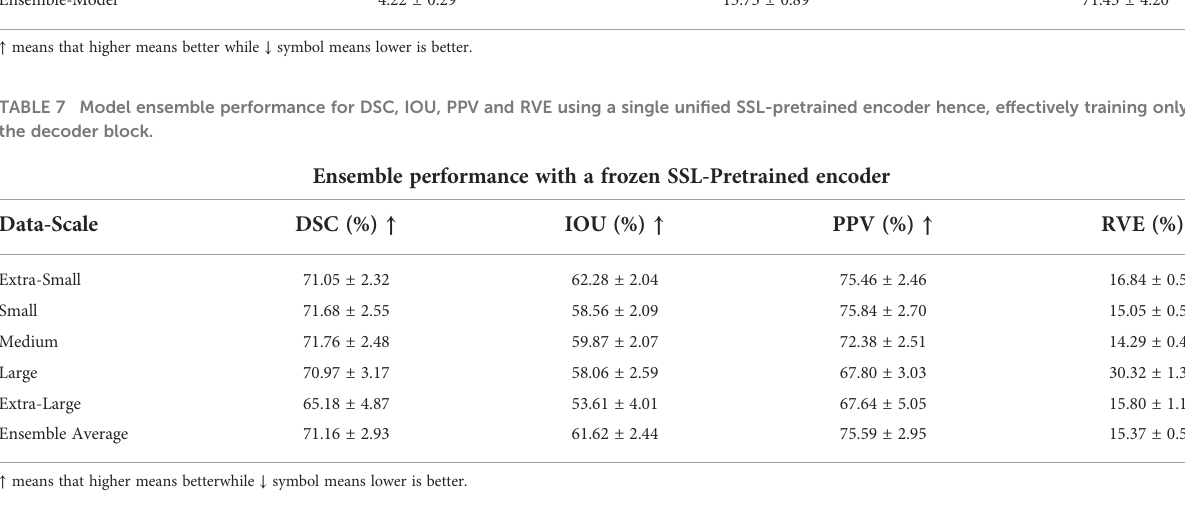
TABLE 8 Distance metric performance results using a single uni fi ed encoder block for multiple decoder for a speci fi c data scale. Distance metric performance with a Frozen SSL-Pretrained encoder